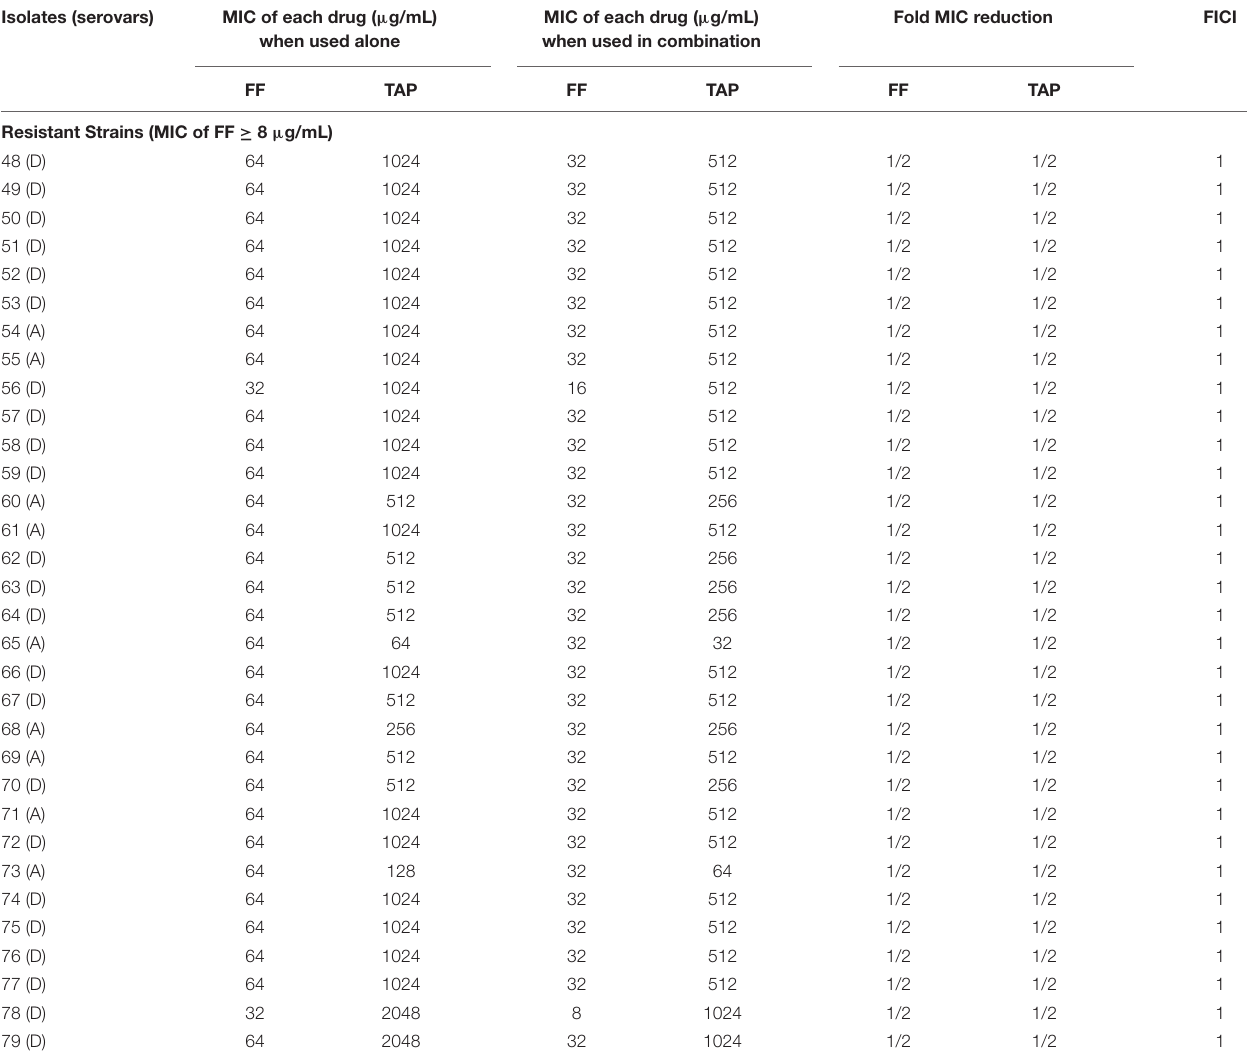
Table S2 ) and protein profiles ( Supplementary Table S3 ) revealed no statistical differences ( P > 0.5) among the five treatment groups with all values falling within or slightly above the normal range. Five days after bacterial challenge, the total white blood cell and neutrophil counts were mostly lower compared to the negative control group, while the lymphocyte, monocyte, eosinophil, and basophil counts were